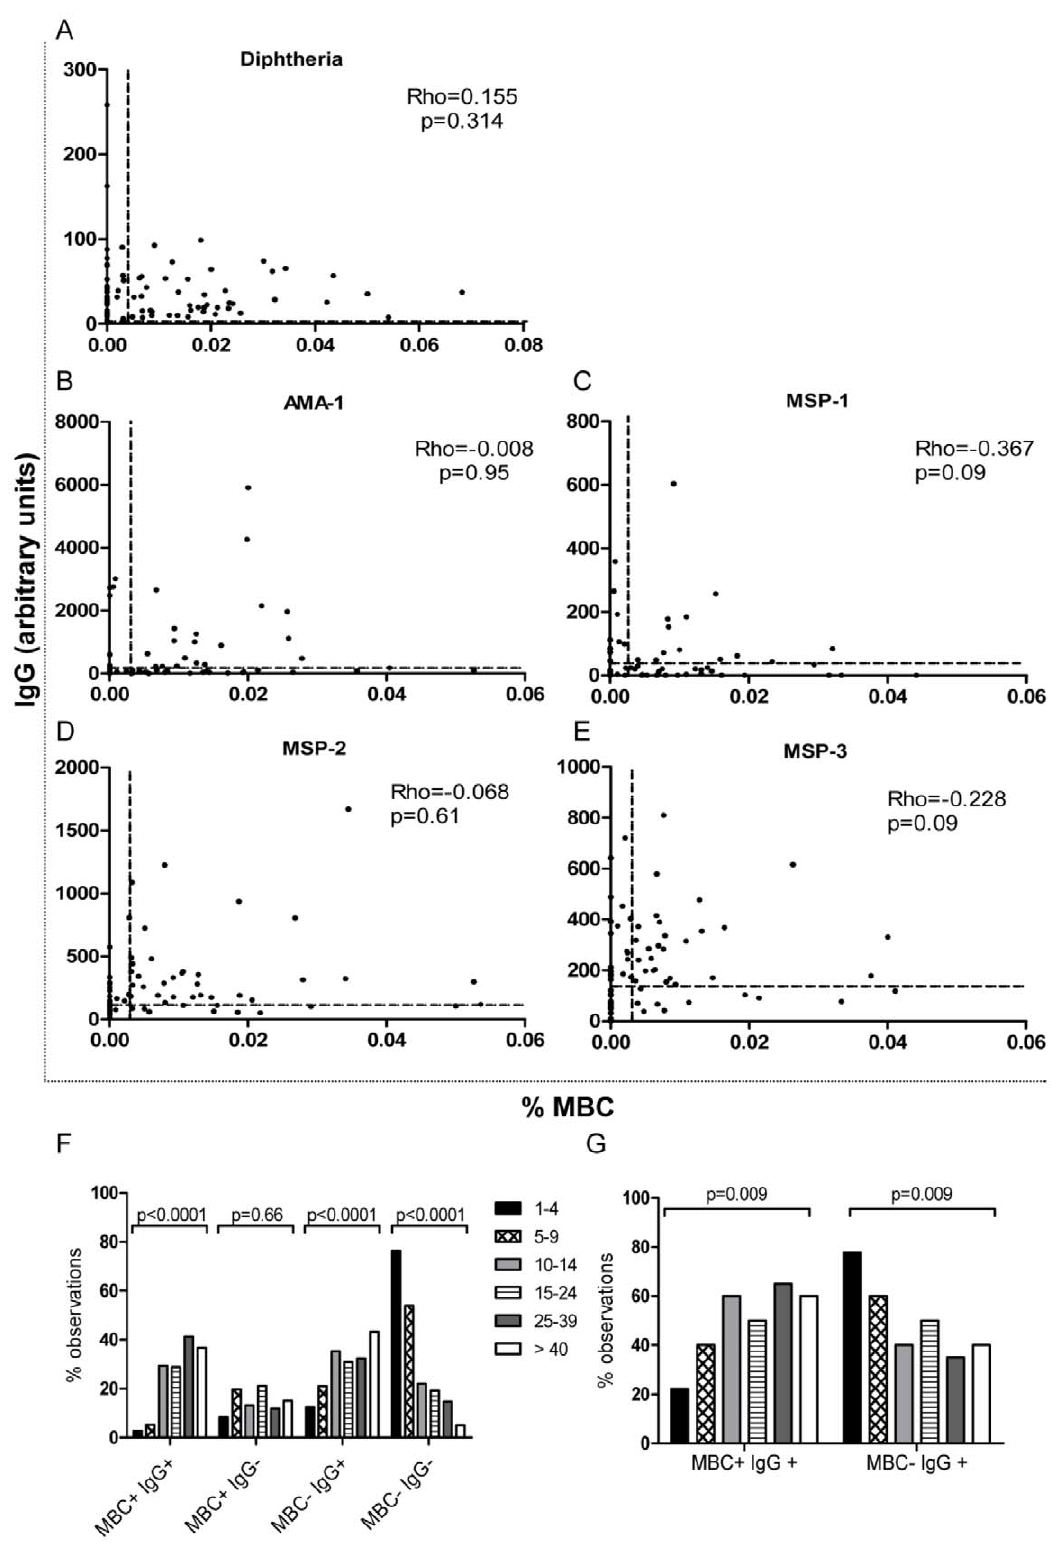
Figure 4. Plasma Ab levels do not correlate with MBC numbers. A–E: correlation plots for Ab versus % MBC. The cut-off values for defining responders are shown by dotted lines parallel toeach axis. The degree of correlation was assessed by calculating Spearman’s correlation coefficient for data points where one or both values were above the cut-off. F–G: Each individual’s response to each Ag were classified as: MBC + IgG + (that is, a response in both the ELISpot and the ELISA was seen), MBC + IgG 2 (ELISpot response but no Ab), MBC 2 IgG + (no ELISpot response but Ab) or MBC 2 IgG 2 (no response in either of the tests). The frequency with which each category occurred in each age group was then expressed as a proportion and is plotted for F) malaria Ag and G) DT. Responder status for MBC was determined using MBC/PBMC. P test for trend values are indicated. doi:10.1371/journal.pone.0025582.g004 PLoS ONE |